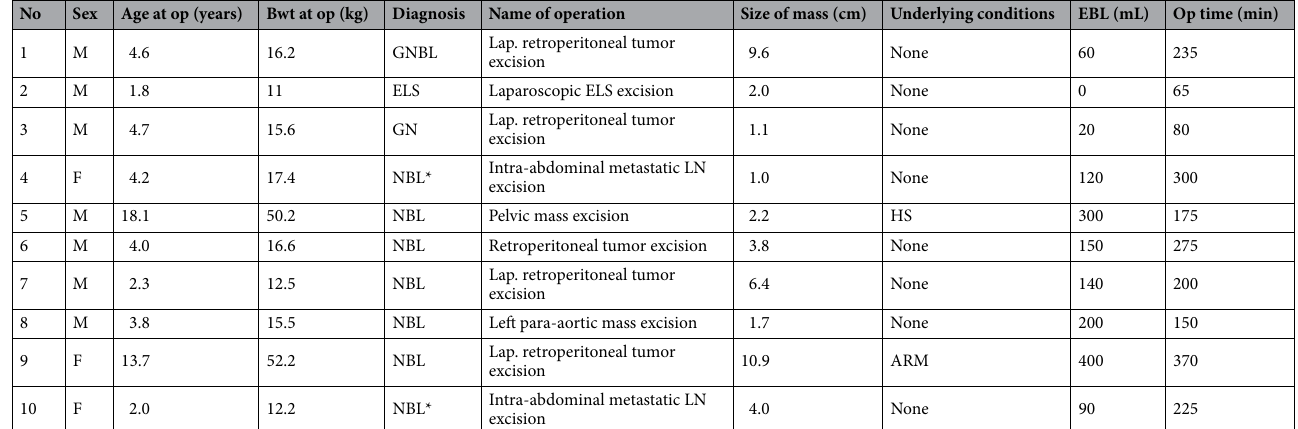
Table 4. Detailed information of enrolled patients. Op, operation; EBL, estimated blood loss; GNBL, ganglioneuroblastoma; ELS; extralobar pulmonary sequestration; GN, ganglioneuroma; NBL, neuroblastoma; *: Mass with intra-abdominal metastasis, LN: Lymph nodes, HS: Hereditary spherocytosis, ARM: Anorectal malformation (Intra-abdominal metastatic LN excision: subhepatic, common ilac, internal iliac, paraduodenal, and mesentery LN excision).